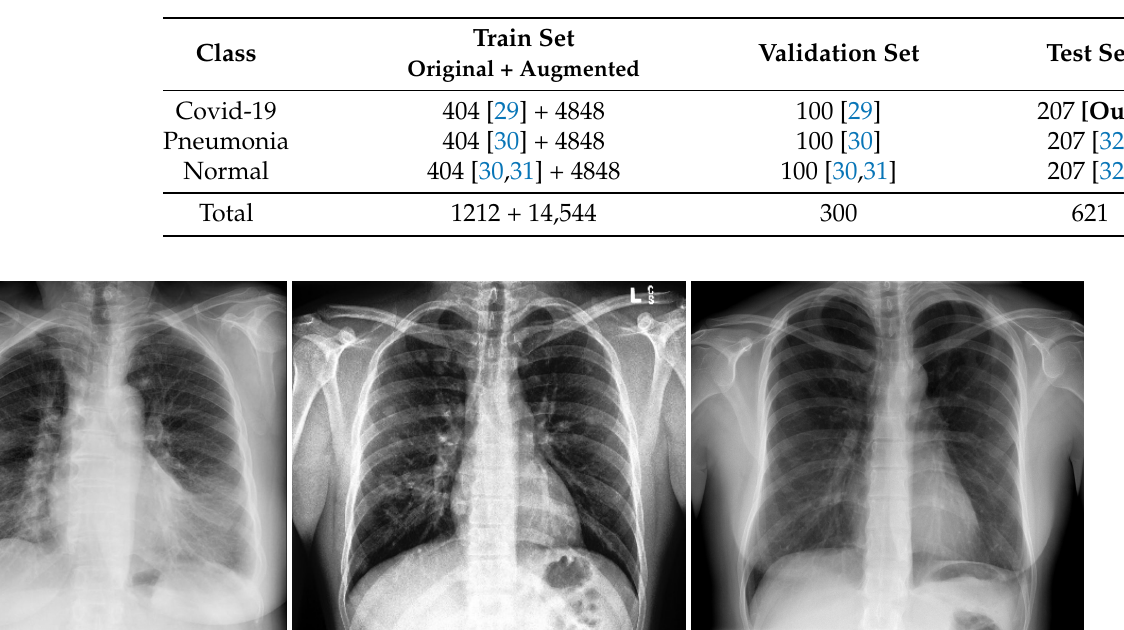
Figure 1. Samples from the three-class Covid-19 database: Covid-19 ( left ), Pneumonia ( center ), and Normal ( right